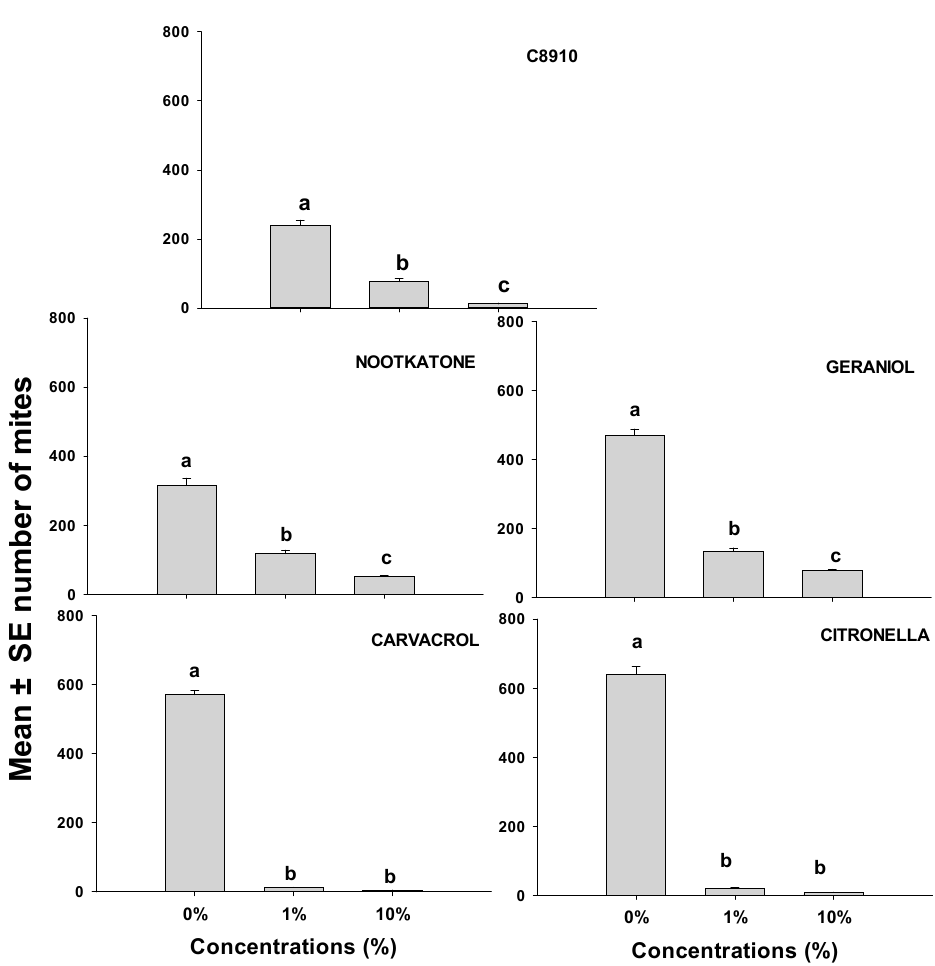
Figure 3. Mean (± SE; n = 5) number of mobile T. putrescentiae progeny 14 days after inoculation of 20 mites on small dry-cured ham cubes treated with either solvent only or one of five different re- pellents at two concentrations. Means with the same letter are not significantly different at p > 0.05 using REGWQ and with ANOVA F-values of 7.29–12.16; p <